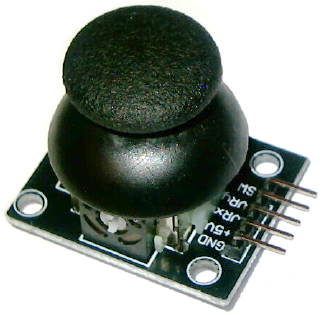
Figure 3. Thumb joystick with button.